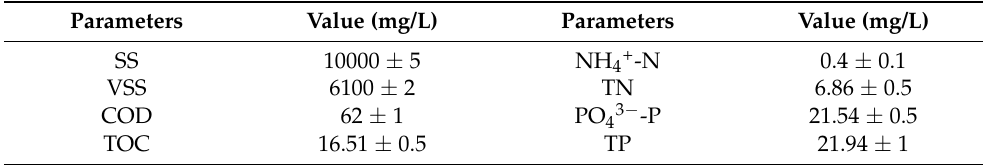
Table 1. Concentration and supernatant characteristics of the excess